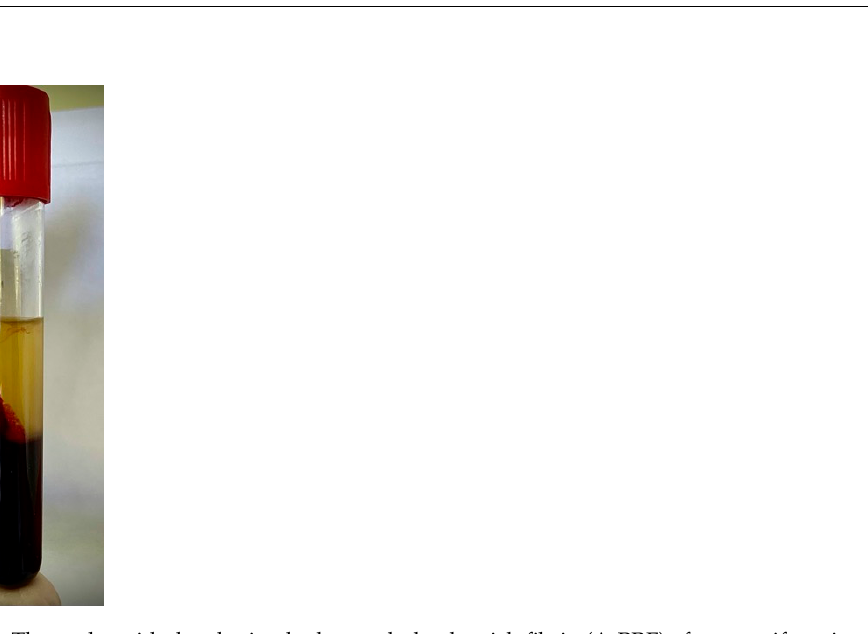
Figure 2. The probe with the obtained advanced platelet-rich fibrin (A-PRF) after centrifugation. Using sterile tweezers, the fibrin clot was squeezed between two gauze pieces to create an autologous fibrin membrane. After the root canal was dried with paper cones, the freshly prepared A-PRF membrane was placed into the apex and then pushed below the level of the cementodentinal junction using Machtou hand pluggers—size 1/2 NiTi (red) and 3/4 (grey).